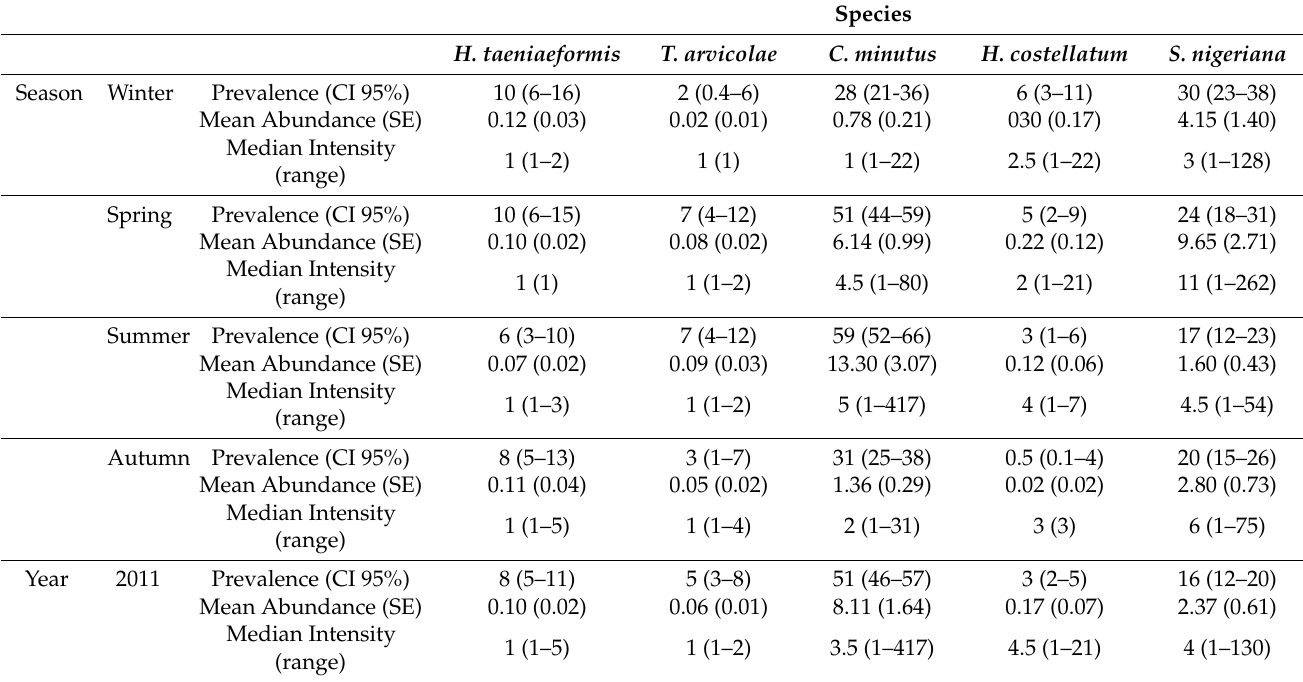
Table 6. Selected characteristics of the five most prevalent helminth species by season and year of capture. CI—confidence interval, SE—standard